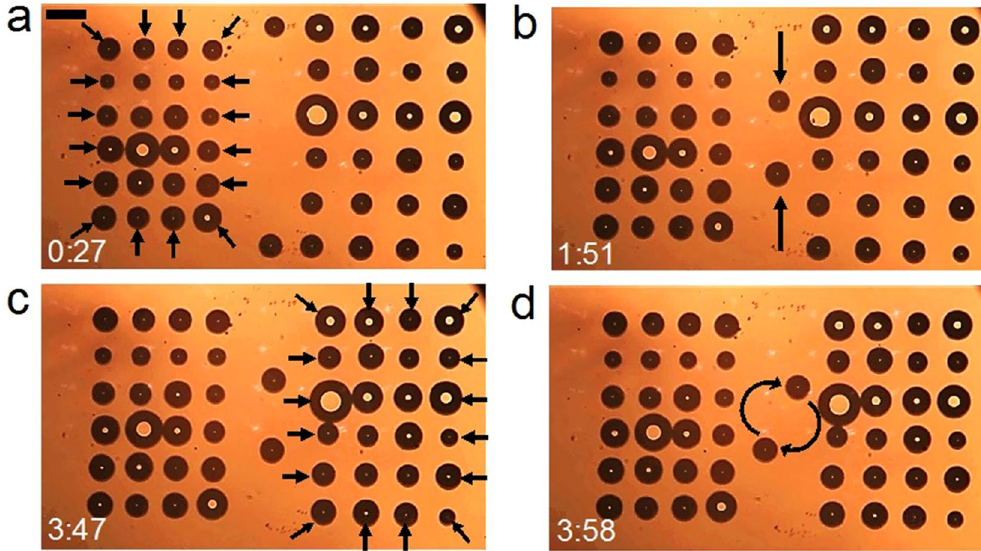
Figure 5. Actuation of subgroups of microrobots in various trajectories. ( a ) The matrix of 24 OFB microrobots at the left side of the workspace was made to contract, as indicated by the arrows. The other 26 microrobots were kept stationary. ( b ) A pair of microrobots were actuated towards each other while the other 48 microrobots were kept stationary, showing independent movement of a small subset of the microrobots. ( c ) The matrix of 24 OFB microrobots at the right side of the workspace was made to contract, as indicated by the arrows, while other twenty-six microrobots were kept stationary. ( d ) A pair of microrobots were actuated along a circular trajectory, first in the clockwise direction, then in the counter-clockwise